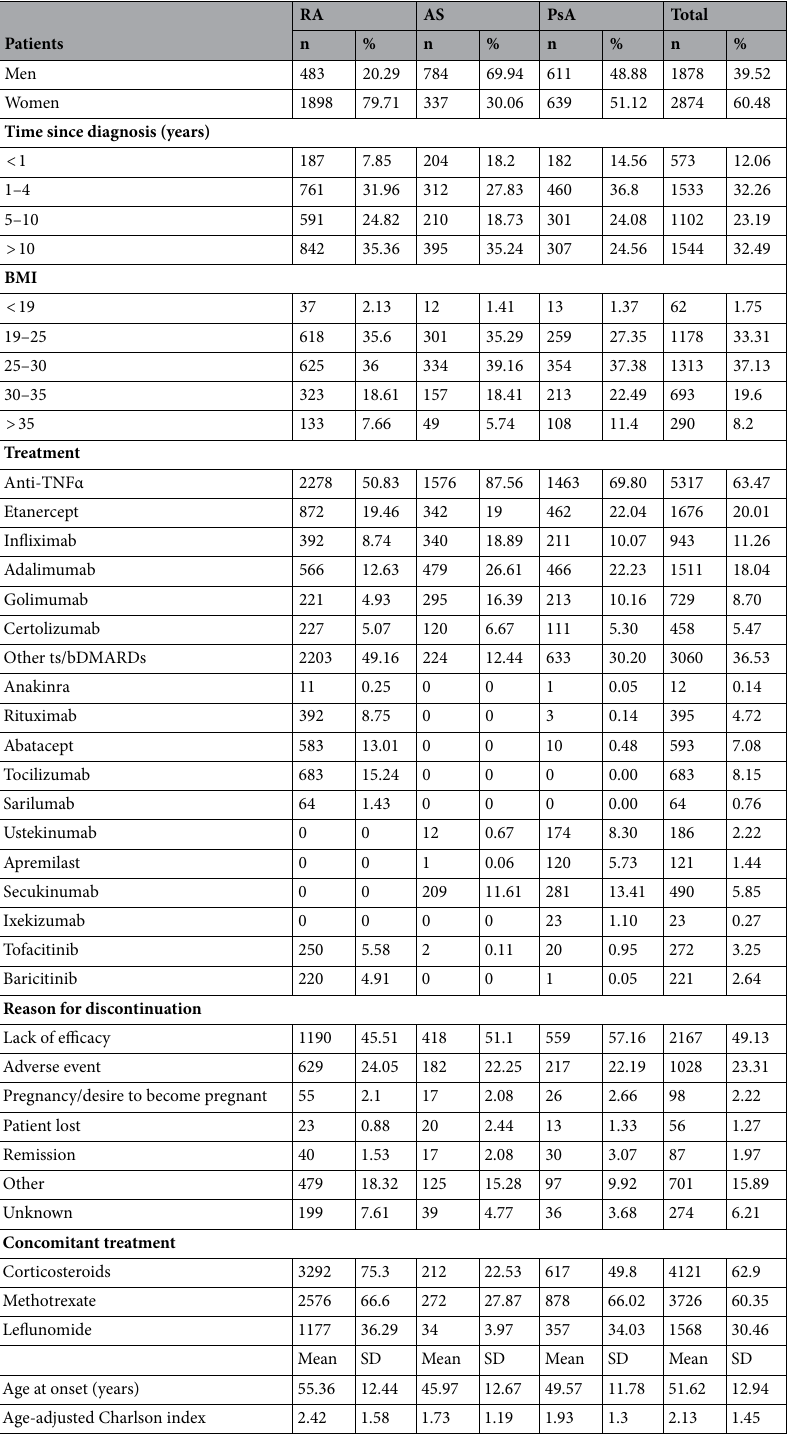
Table 1. Baseline clinical characteristics of patients and type of treatment. RA rheumatoid arthritis; AS ankylosing spondylitis; PsA psoriatic arthritis; BMI body mass index; SD standard